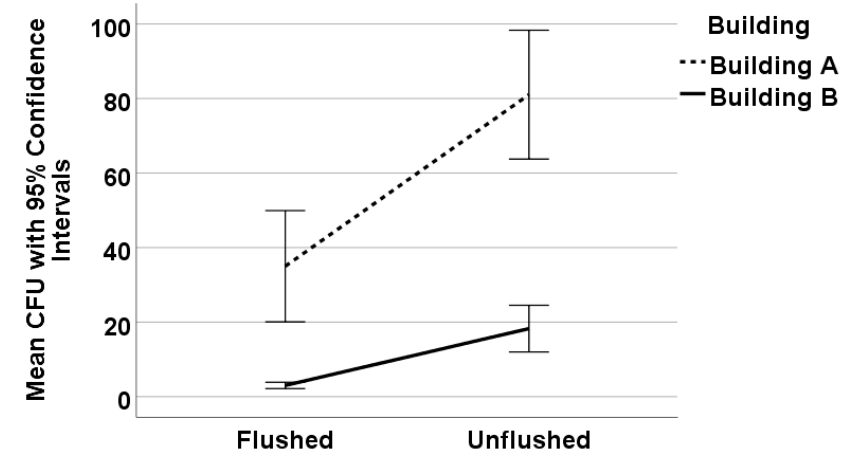
Figure 2. Mean Legionella counts (CFU / mL) as a function of flushing by building. Table 2. Descriptive statistics of Legionella based on processing and collection method.